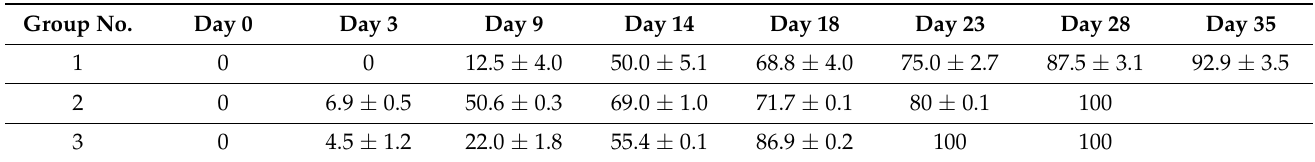
Table 3. Dynamics of full-thickness skin wound healing in Wistar rats (standard deviation values for five independent measurements are